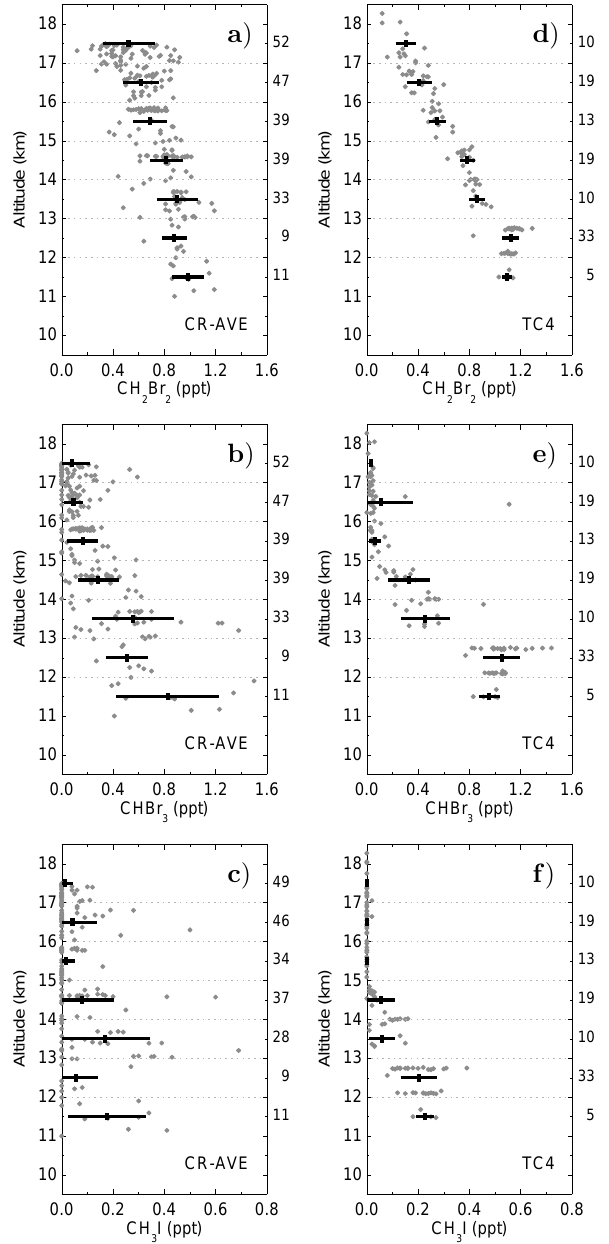
Fig. 8. Selected halocarbons measured by whole air sampler aboard the WB-57 during CR-AVE (a–c) and TC4 (d–f) . Plots (a) and (d) show CH 2 Br 2 , (b) and (e) show CHBr 3 , and (c) and (f) show CH 3 I; so lifetimes decrease from top to bottom. The number of measure- ments in successive 1km altitude bins is noted to the right of each plot. The solid black lines show the mean ± 1 standard deviation in each